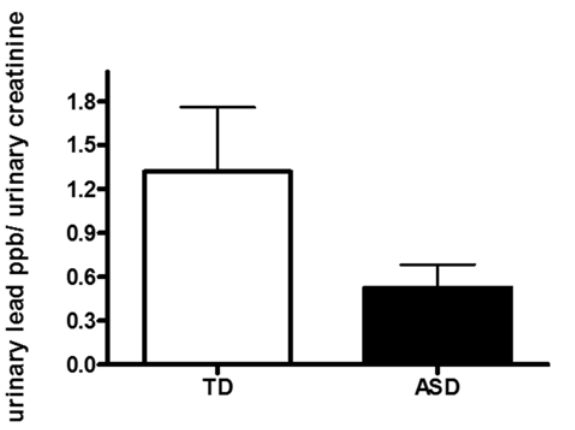
Figure 1. Urinary concentration of lead (Pb) in children with autism spectrum disorder (ASD) and typically developing children (TD).